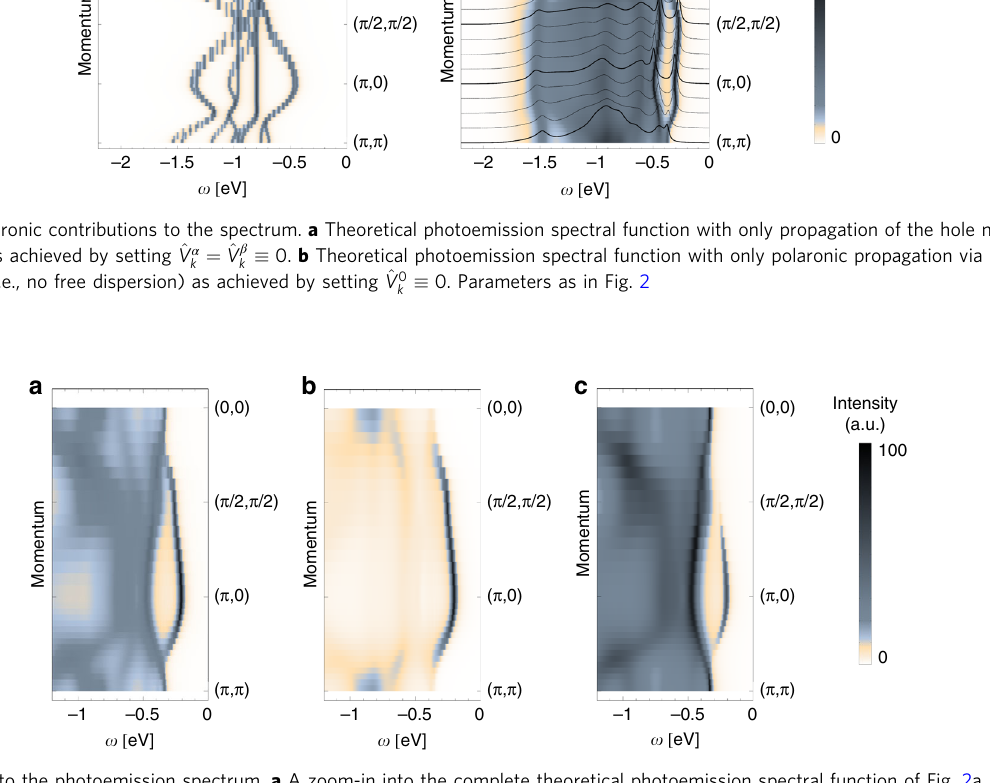
Fig. 4 A zoom-in into the photoemission spectrum. a A zoom-in into the complete theoretical photoemission spectral function of Fig. 2a. b , c As a but J -resolved — with b showing the J = 0 contribution (motion of a “ singlet hole ” ) and c the J = 1 contribution (motion of a “ triplet hole ”